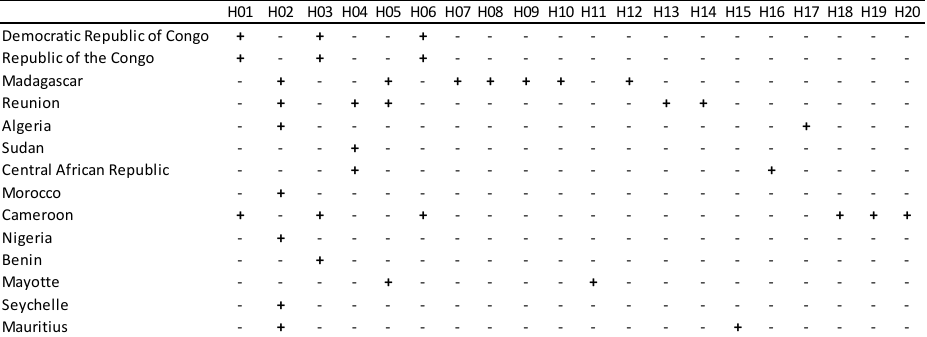
Figure 3. Aedes albopictus haplotype distribution among African countries. Countries or regions where a haplotype is present are indicated by (+), whereas, the absence of the haplotype is indicated by (−).